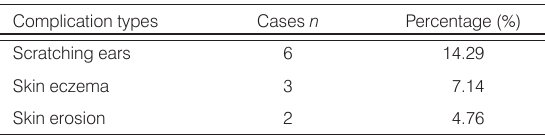
Table 2. Complications observed during